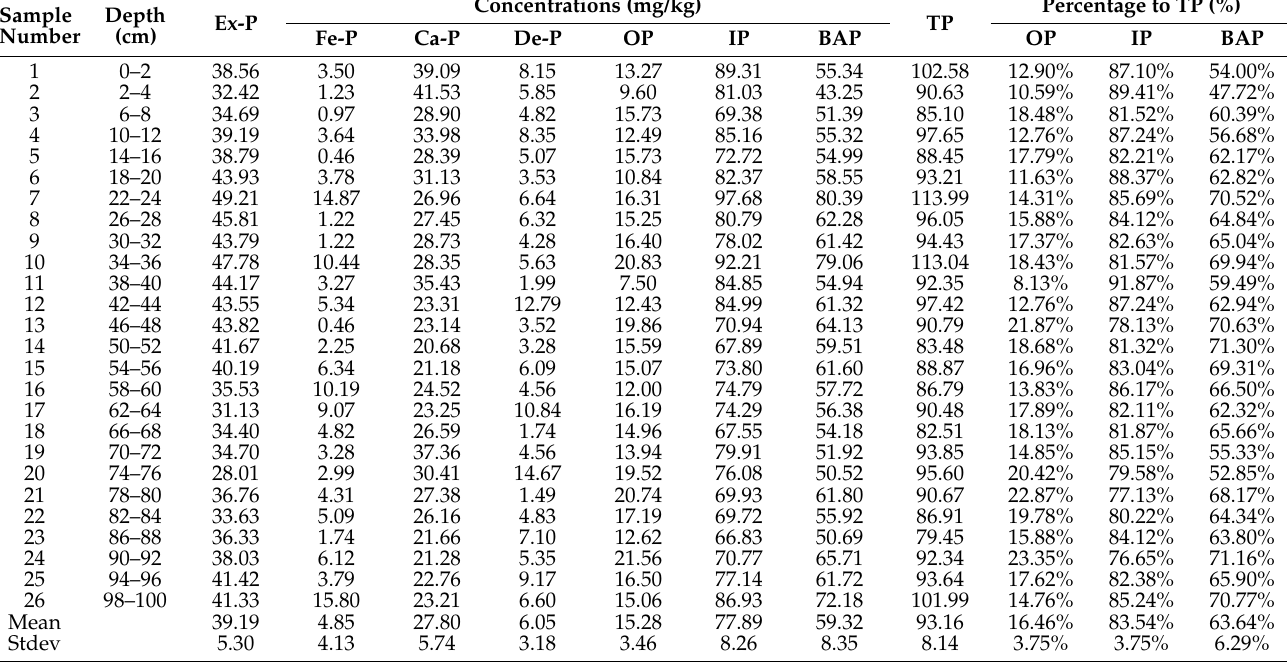
Table A1. Sampling site